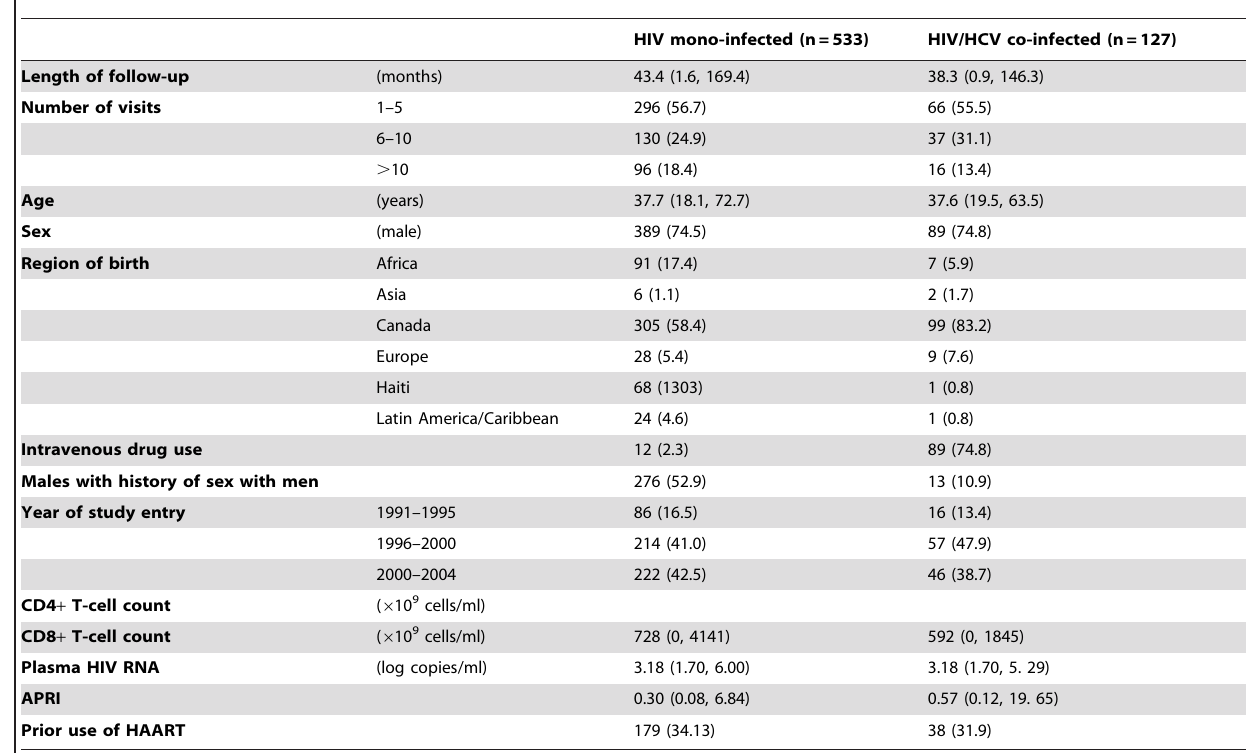
Table 2. Baseline characteristics according viral co-infection status (individuals used to assess the by-interval effects).